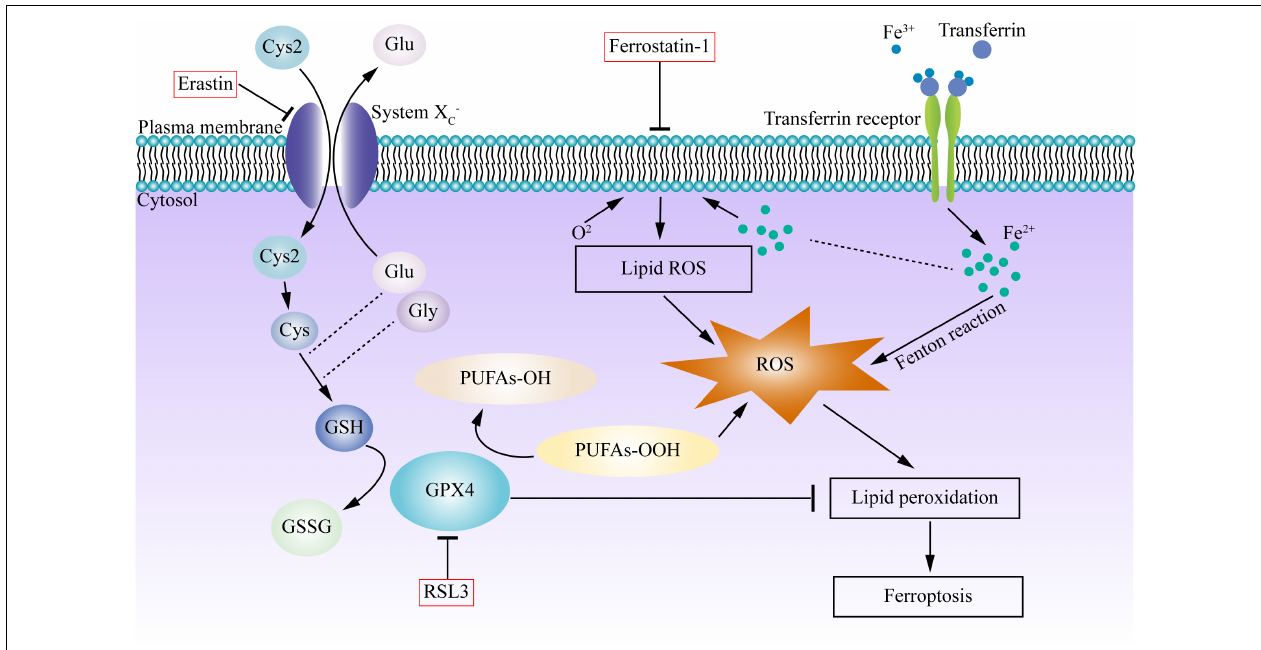
FIGURE 1 | Graphic mechanisms of ferroptosis. Dysregulation of intracellular iron metabolism or glutathione peroxidation pathways leads to accumulation of lipid ROS and eventually causes ferroptosis. Various inducers and inhibitors are shown in the red box. Arrows indicate promotion; blunt-ended lines indicate inhibition. Excessive free irons are the foundation for ferroptosis execution. Circulated Fe 3 + was combined with transferrin, and then entered into cells by transferrin receptor. Iron in Fe 3 + form was deoxidized into iron in Fe 2 + , the latter generated ROS by Fenton reaction. System Xc- is an antiporter that imports cystine and exports glutamate, providing cysteine for glutathione synthesis, can be inhibited by erastin. GPX4 is a redox enzyme which reduces reactive aldehydes (PUFAs-OOH) to their alcohol form (PUFAs-OH), reduces ROS accumulation, plays important roles in the regulation of ferroptosis. RSL3 directly inhibit GPX4, which inhibits lipid peroxidation and prevent cell death, triggering the accumulation of ROS and boost ferroptosis. Ferrostatin-1 reduced the production of lipid ROS and attenuated ferroptosis. Cys, cysteine; Cys2, cystine; Glu, glutamate; Gly, glycine; GSH, glutathione; GSSH, glutathione disulfide; GPX4, glutathione peroxidase 4; PUFA, polyunsaturated fatty